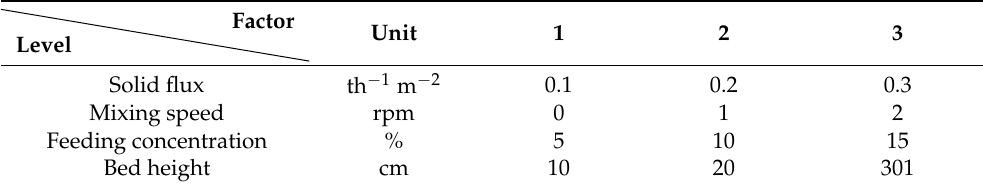
Table 2. Selection of test factors and levels.